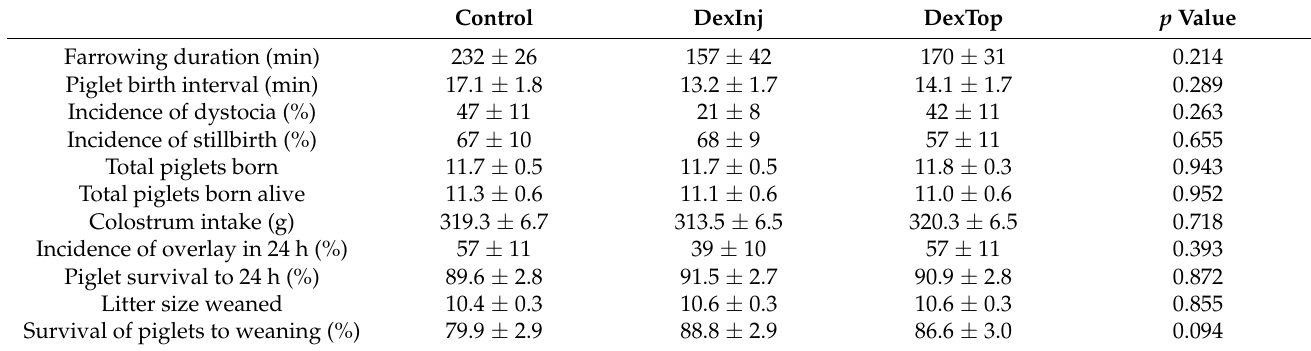
Figure 4. A diffusion profile of dexamethasone treatment through porcine vaginal mucosa in-vitro fitted by Makoid – Banakar model ( F = kMB × t n × Exp( − k × t ). r 2 adjusted = 0.9871 and AIC =39.2. Table 2. Effects of dexamethasone administered the day of farrowing (0700 h, gestation day 115) as a vulval injection (DexInj), applied topically into the vagina (DexTop), or no treatment (Control) on mean ( ± SE) sow and piglet performance